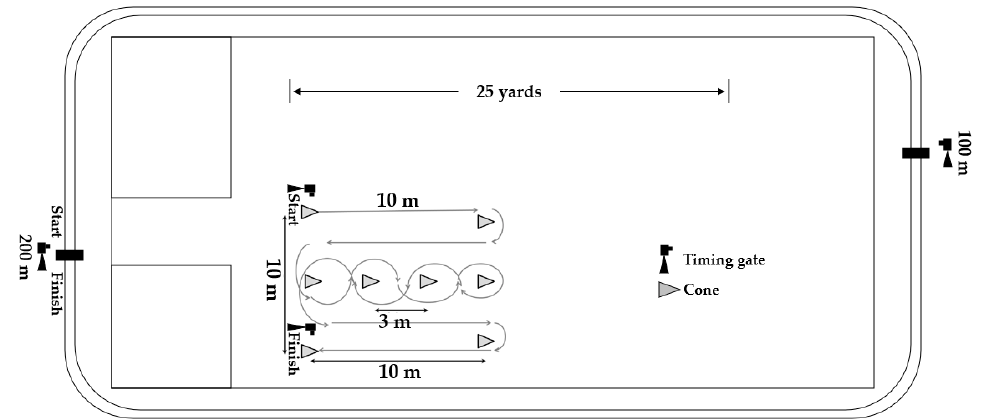
Figure 1. Schematic of test positioning.